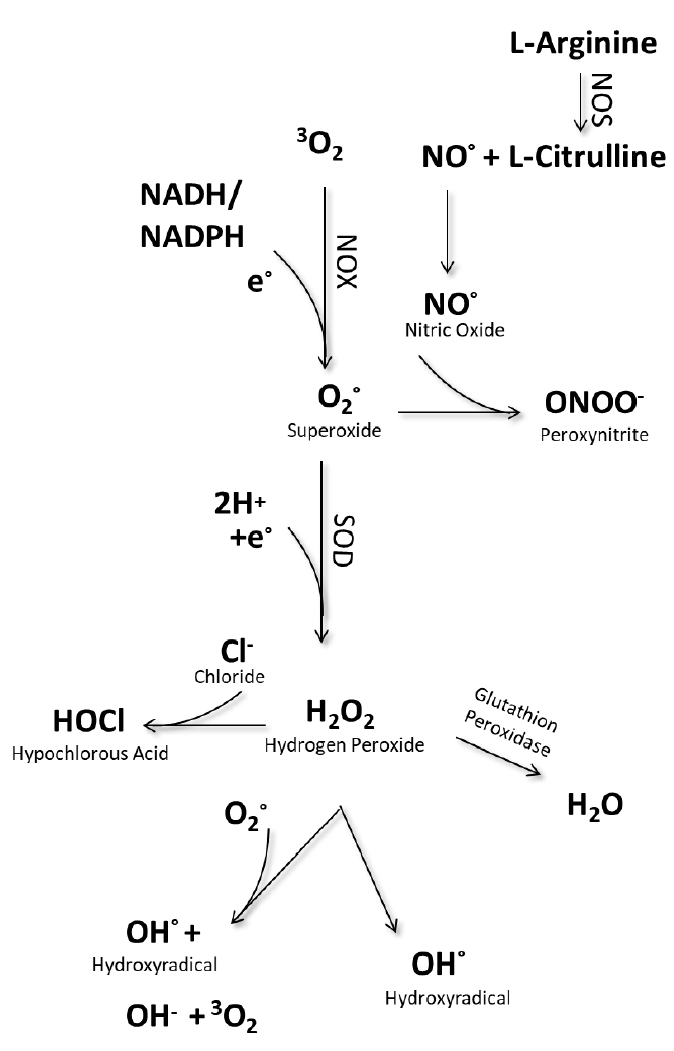
Figure 1. Intracellular generation of reactive species.